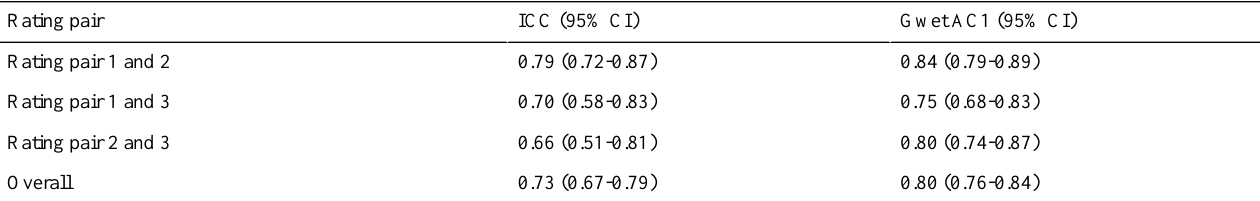
Table 1. Intraclass correlation (ICC) estimates and Gwet AC1 statistics for all rating pairs.